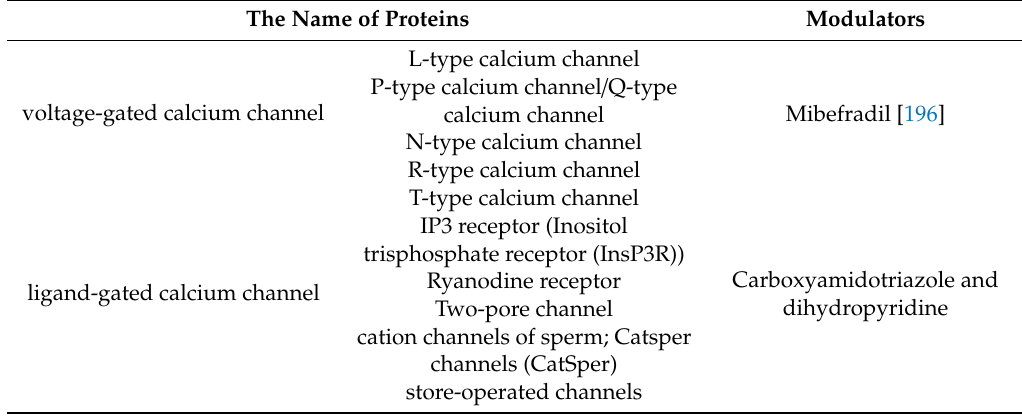
Proteins that regulate calcium ion dynamics involved in carcinogenesis with potential modulators.